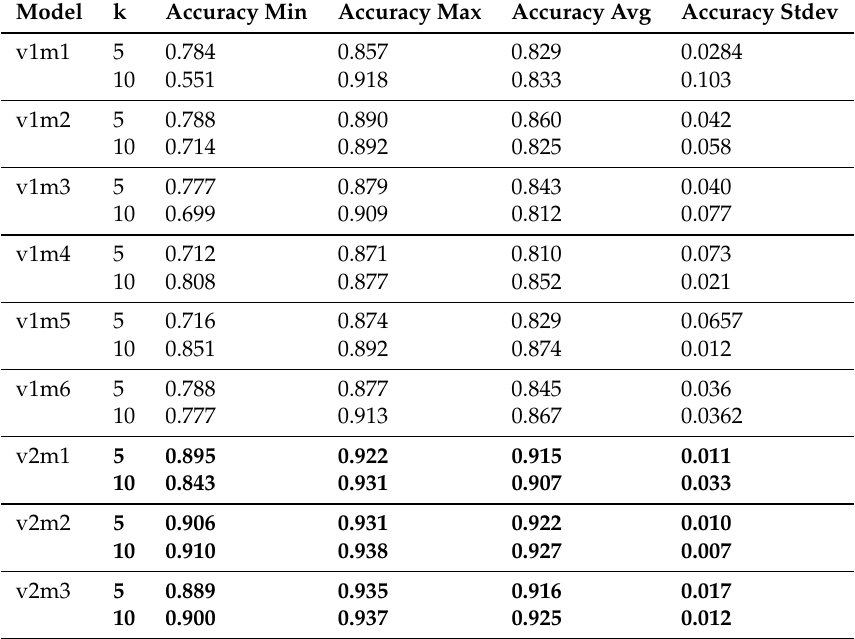
Table 2. K-fold test accuracy results for best designed networks (selected by validation accuracy) for the IGN-PNOA dataset.